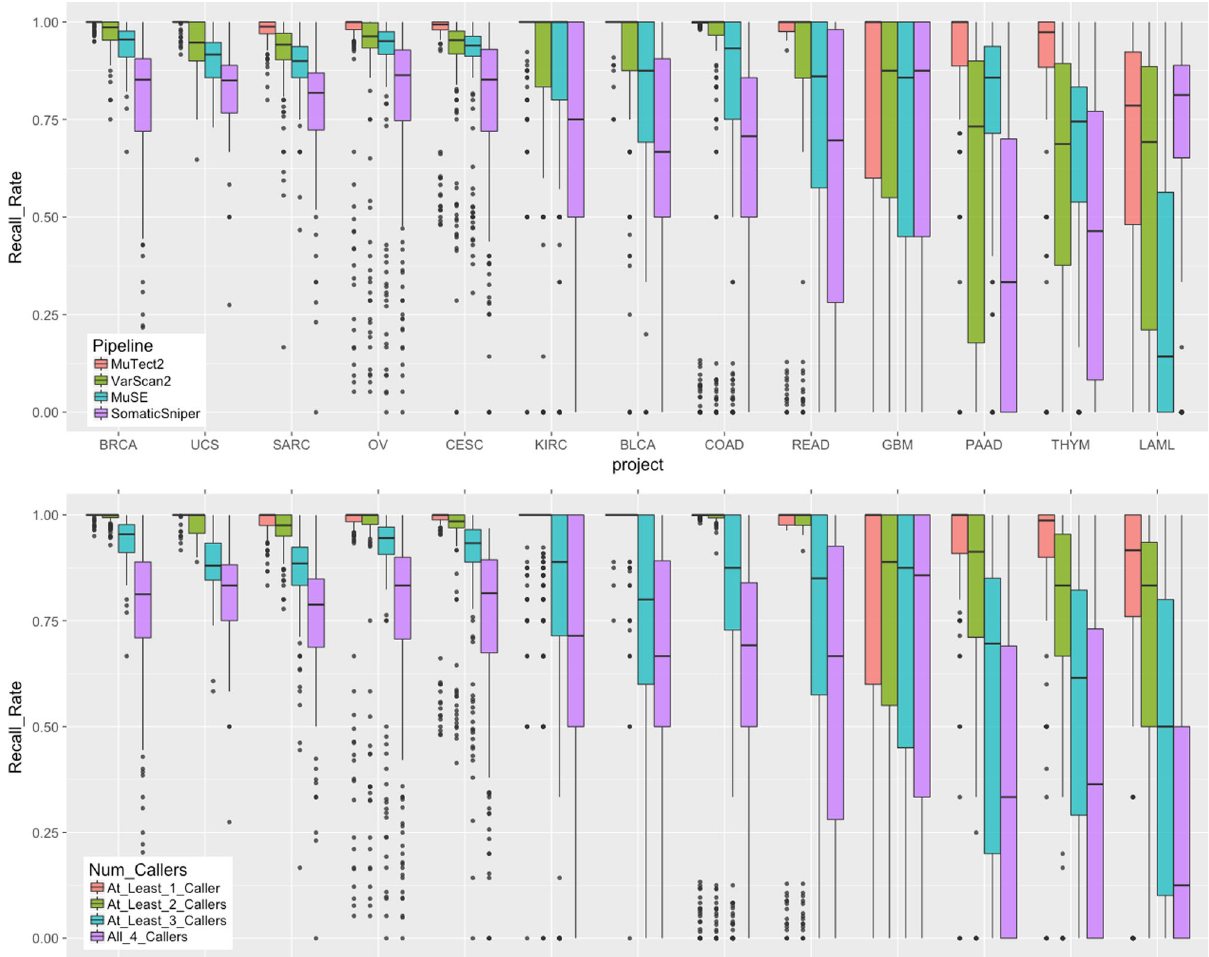
Fig. 3 Recall rate of TCGA validated variants by project. In both plots, n = 125/123/192/182/223/141/215/148/48/200/107/57 biologically independent samples for projects BLCA/BRCA/CESC/COAD/KIRC/LAML/OV/PAAD/READ/SARC/THYM/UCS, respectively. Top: Boxplots of recall rate of TCGA validated variants by 13 projects and four GDC somatic variant calling pipelines. Each dot represents a unique tumor sample. Projects are ordered by decreasing average recall rate from left to right. Bottom: Boxplots of recall rate of TCGA validated variants by number of pipelines